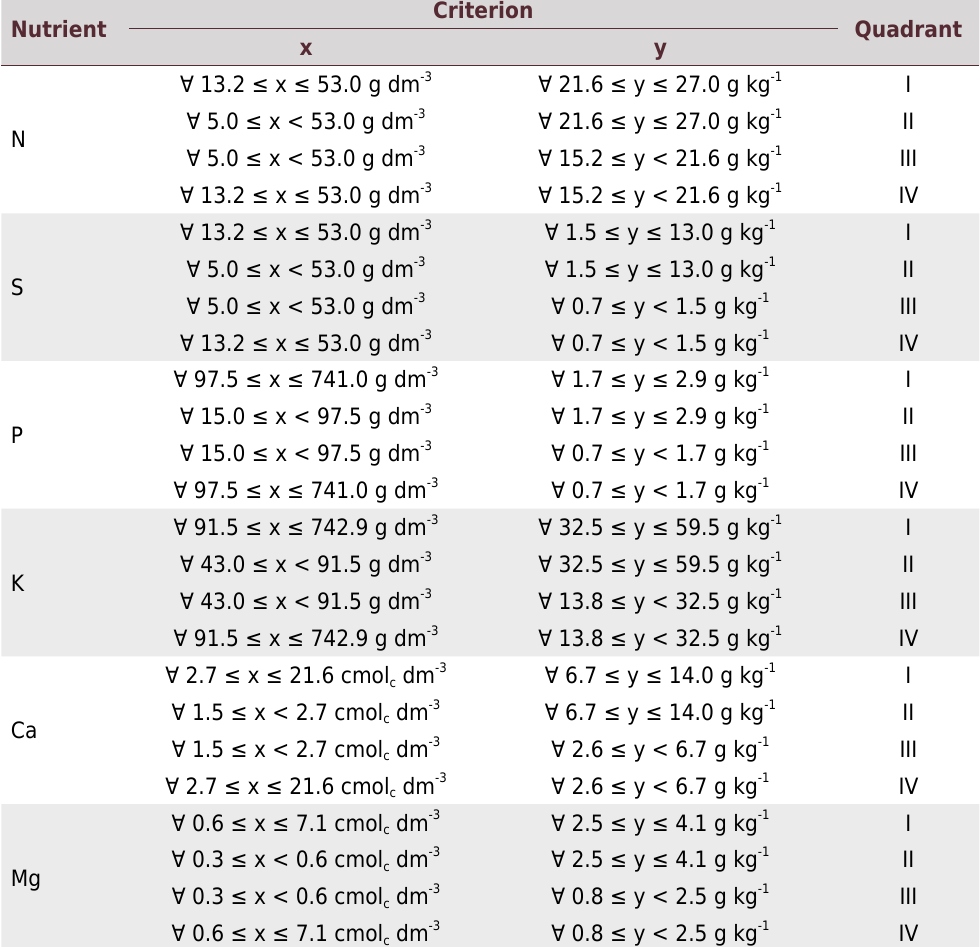
Table 4. Criteria established by the Quadrant Diagram of the Plant-Soil Relationship (QDpsR) method to classify the plots